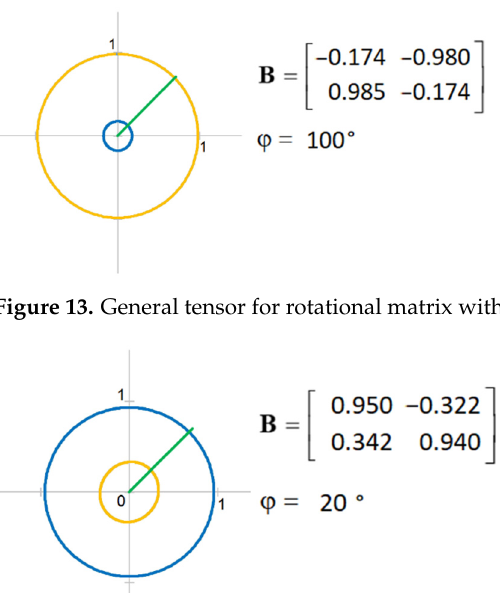
Figure 12. General tensor for rotational matrix with angle 𝜑 = 45° .